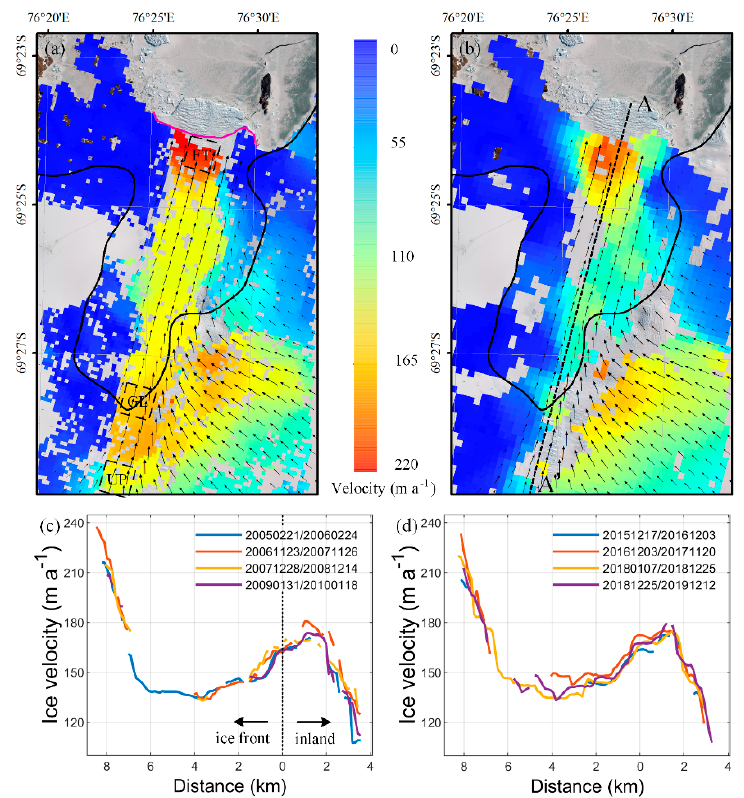
Figure 3. Surface ice velocity at Dalk Glacier. ( a ) Surface velocity map derived from Landsat 7 images (20050221 / 20060224). The black and pink lines are the grounding line and southernmost terminus position on 28 January 2011. The black dashed rectangular boxes are regions for temporal velocity analysis. ( b ) Surface ice velocity derived from Sentinel-1 images (20160807 / 20160831). AA’ is the location of the centerline profile. ( c ) and ( d ) are interannual velocity variations along AA’ before and after large calvings in 2006 and 2016, respectively. The black dashed line shows the position of the grounding